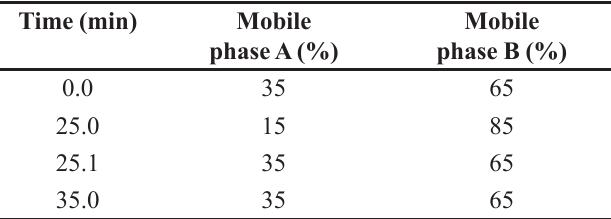
TABLE I - Mobile phase gradient